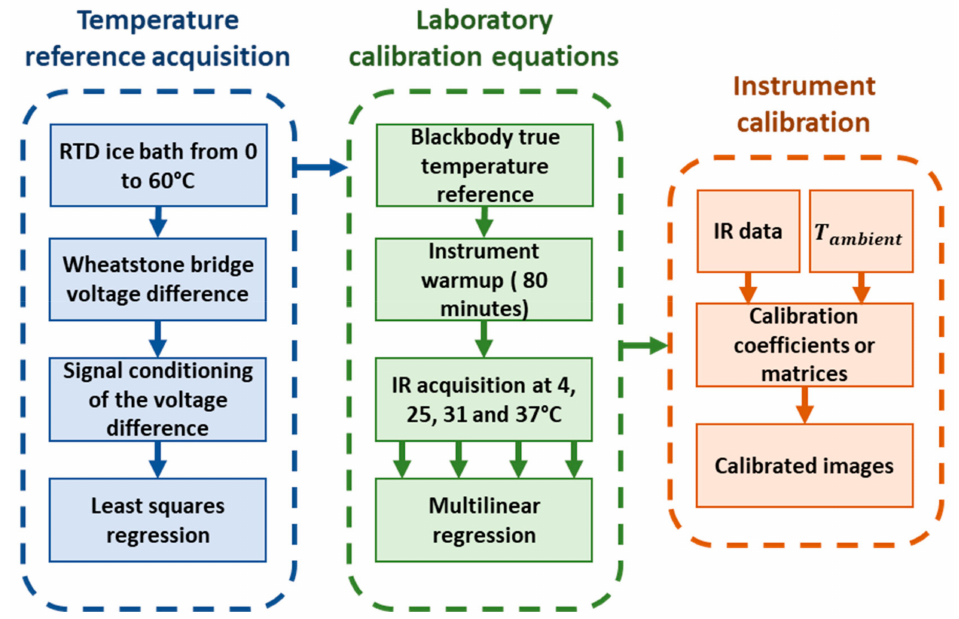
Figure 2. Schematic of the calibration workflow. The first step was to produce a reliable temperature reference and then collect infrared temperature information at multiple temperatures in an environmental chamber to fit the data to the temperature reference using multilinear regression (MLR) to produce calibration equation matrices. Finally, these calibration matrices were applied to the uncalibrated thermal infrared data. This approach corrects for the ambient temperature e ff ect as well as non-uniformity for each individual pixel in the